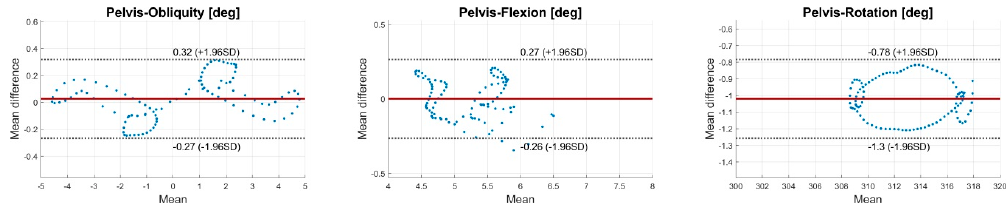
Figure A3. BA diagrams of 3D joint rotations of hip, knee and ankle of the right side for condition 1. The solid line indicates the mean difference. The dashed lines indicate the LoA (95% CI of the mean difference).